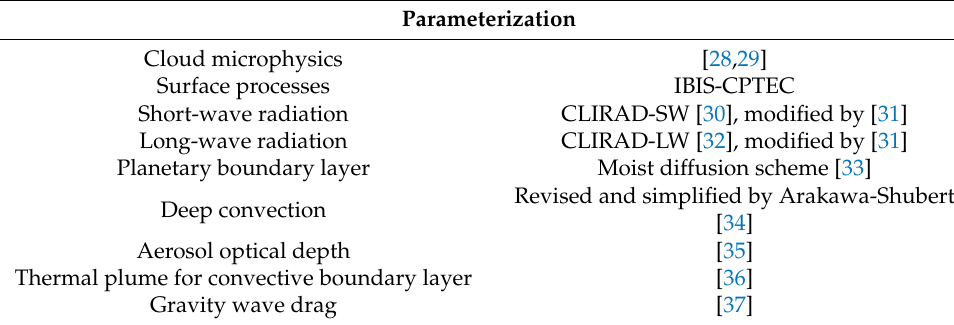
Table 1. Components of physical processes of